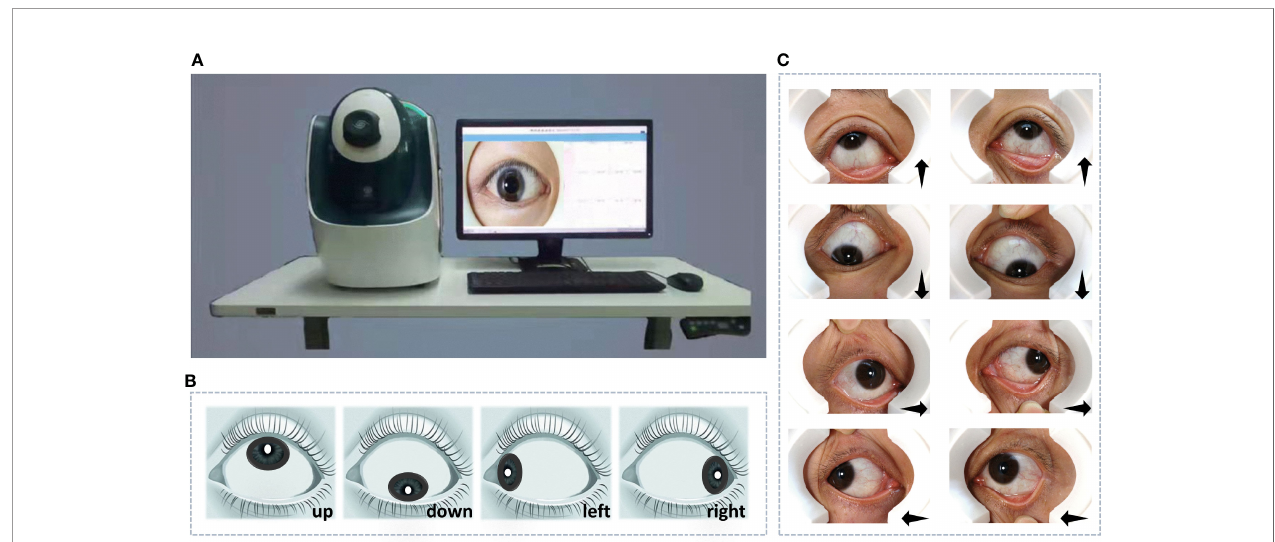
FIGURE 1 | The device for data acquisition and data collected for experiments. (A) The specially designed device. (B) The diagram of re fl ection-shadows-free scleral images. (C) Images of the left and right eyes with eyeballs rotating in different directions: up, down, left, and